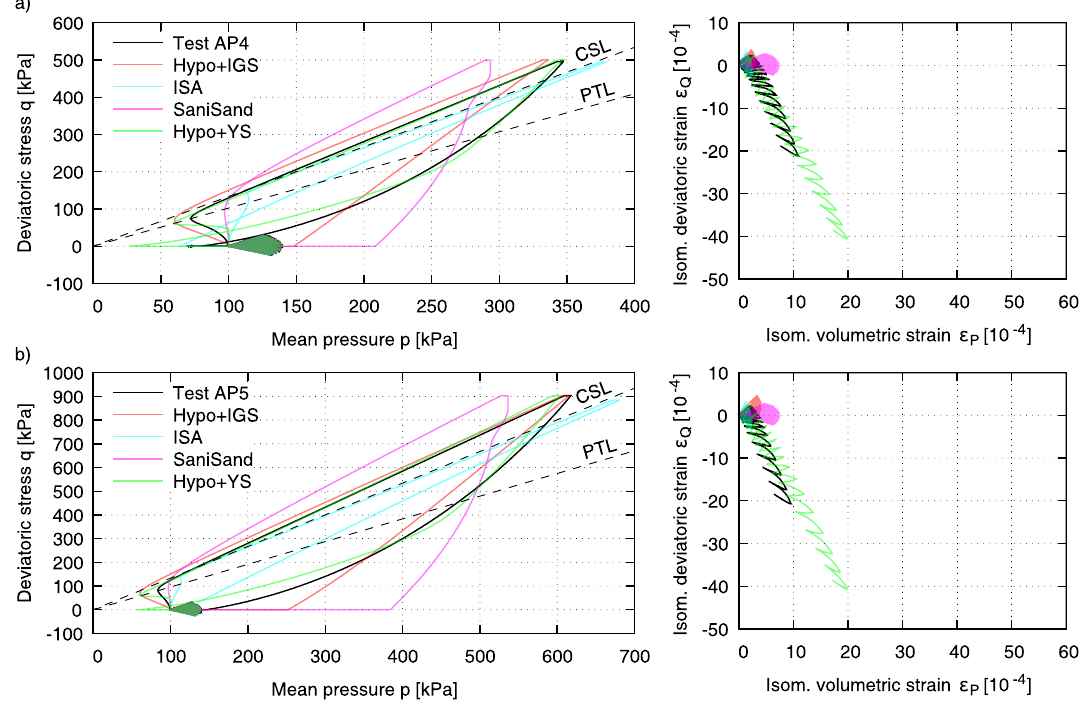
Figure 11. Simulations of tests AP4 (large undrained preshearing along CSL in triaxial compression) and AP5 (large undrained preshearing along CSL in triaxial